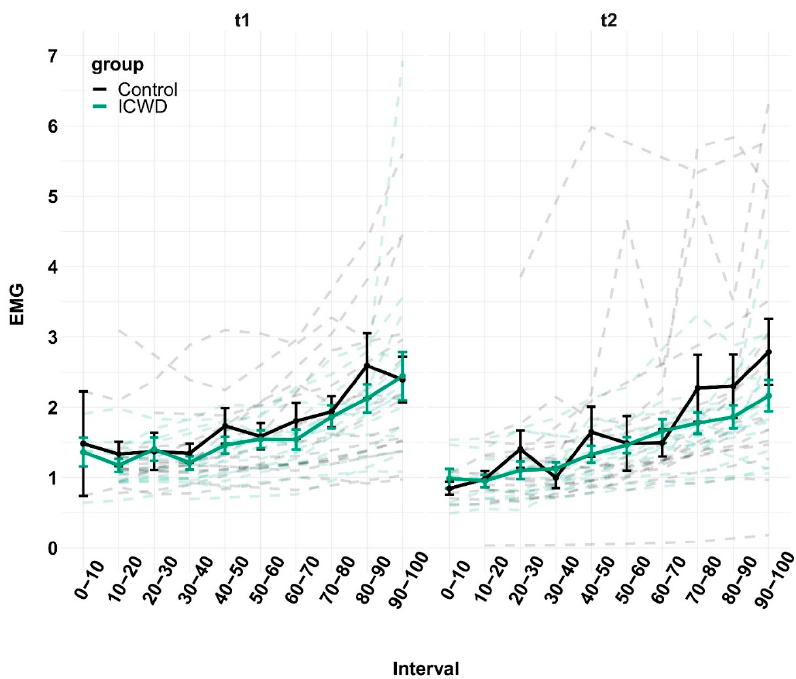
Figure 5. EMG. Mean rms EMG, normalized to Mmax (%), are displayed throughout the time normalized task (Interval) during the first (t1) and second (t2) experimental session for the control (black) and ICWD (green) groups. The dashed lines correspond to individual data. Error bars correspond to SEM.